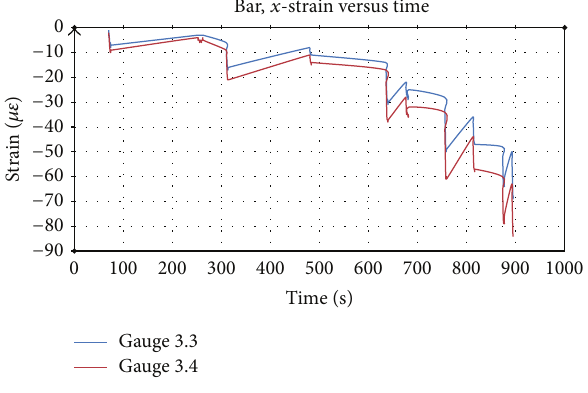
Figure 41: Bar, 𝑥 strain in gauges 3.3 and 3.4.